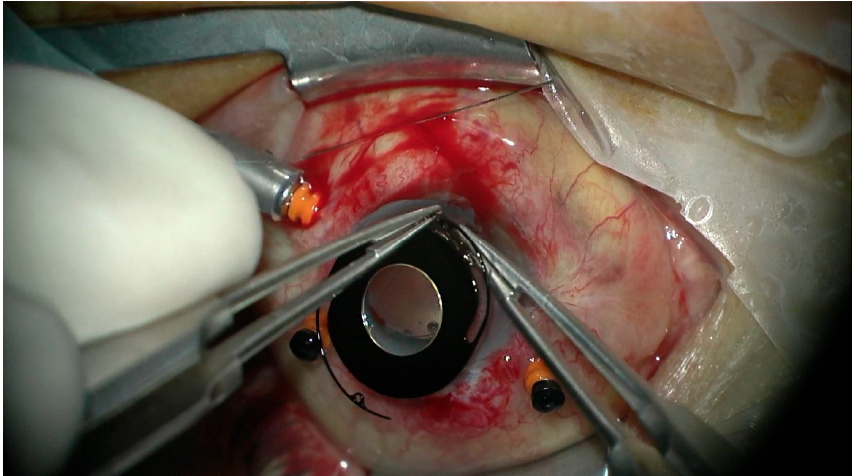
Figure 5. Tying the sutures to the eyelets of the black diaphragm intraocular lens.